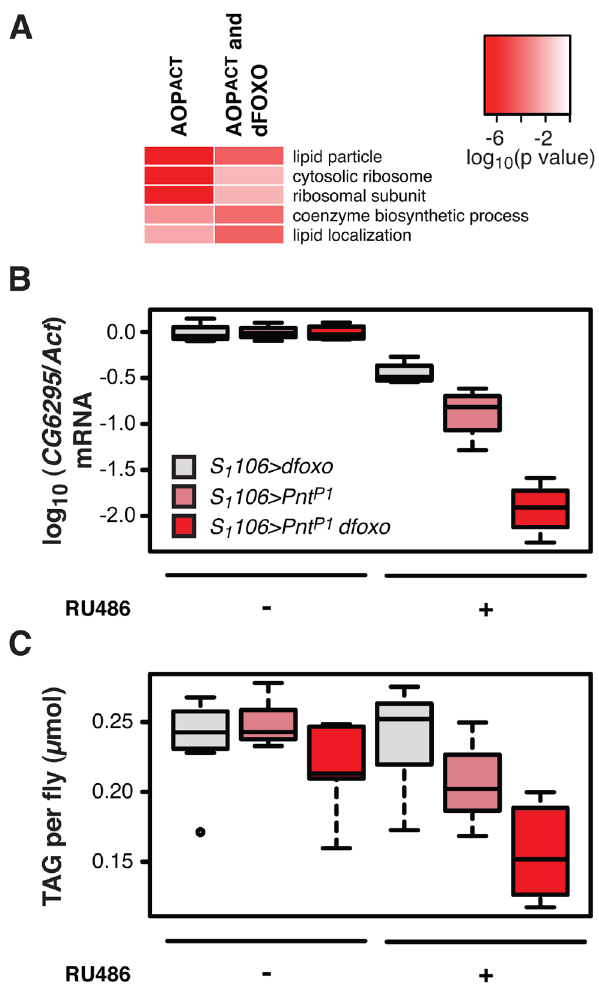
Figure 6. dfoxo and Pnt act synergistically on lipid metabolism. A Top three most significantly enriched GO categories within genes bound by FLAG-AOP ACT alone or FLAG-AOP ACT and dFOXO, as determined by EASE analysis. The intensity of red indicates log-10 derived p value associated with the enrichment. The complete GO analysis is given in Dataset S1 . B CG6296 mRNA was quantified relative to Act by qPCR in the females of the indicated genotypes, induced or not with RU486. Boxplots show log-10 derived relative expression with 2 RU486 values set to zero. Data were analysed with a linear model and the effects of RU486, genotype and their interaction were significant (n=4, p , 10 2 4 ), with S 1 106 . dfoxo Pnt P1 + RU486 condition being different to all others (t-test , p , 10 2 4 ). C The levels of TAG were quantified under the same conditions as in B. Data were analysed with a linear model and the effects of RU486 (p=2 6 10 2 4 ), genotype (p , 10 2 4 ) and their interaction (p=0.01) were significant (n=8, where 10 measurements were made and the lowest and highest measurement removed from each group). The S 1 106 . dfoxo Pnt P1 + RU486 condition was different from all others (t-test , p , 0.05). The genotypes are denoted with the same colours in B and C, with the legend given in B.